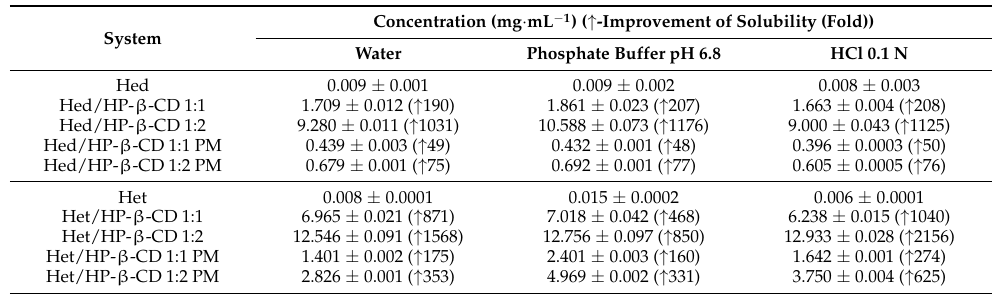
Table 1. The results of solubility studies of Hed and Het systems and physical mixtures. ↑ means Multiple relationships compared to Concentrations of Hed or